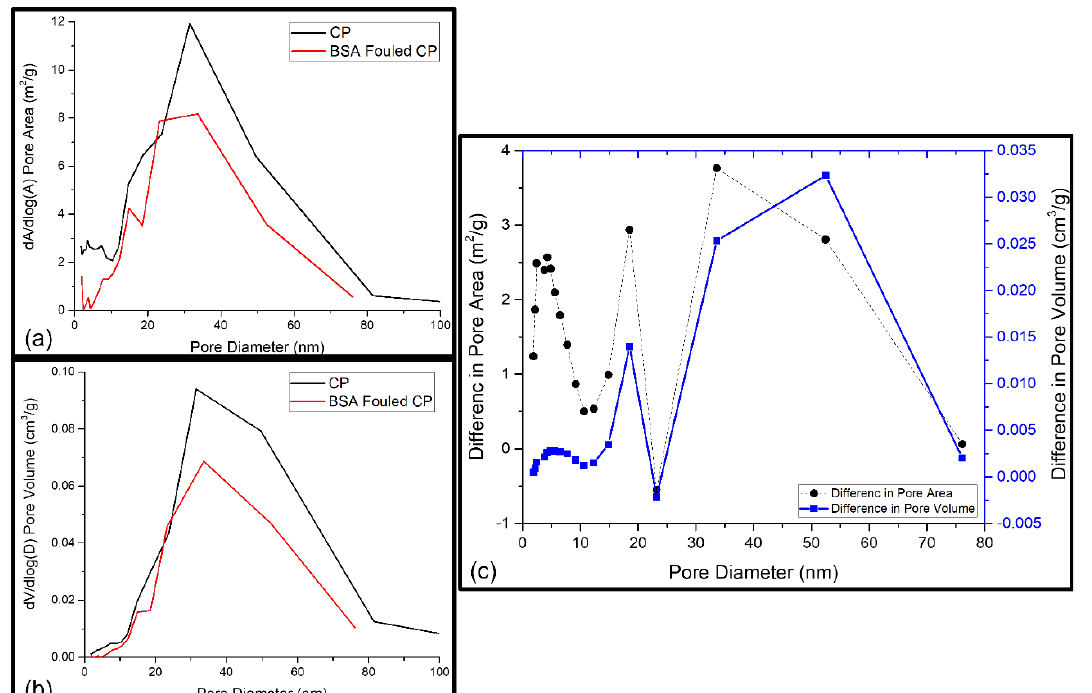
Figure 6. ( a ) BET pore area distribution of CP and BSA-fouled CP membranes; ( b ) BET pore volume distribution of CP and BSA-fouled CP membranes; ( c ) the difference between the pore area of CP and BSA-fouled CP and the difference between the pore volume of CP and BSA-fouled CP as a function of pore diameter.